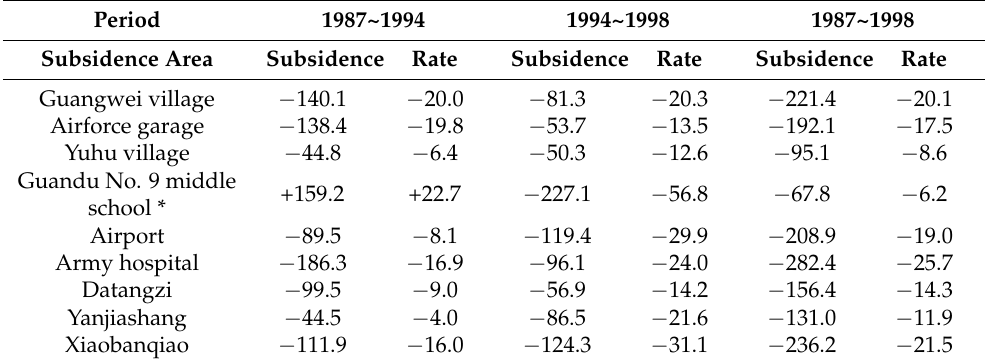
Table 1. Subsidence amount (mm) and subsidence rate (mm · a − 1 ) of Kunming subsidence center. Period 1987~1994 1994~1998 1987~1998 Subsidence Area Subsidence Rate Subsidence Rate Subsidence Rate Guangwei village